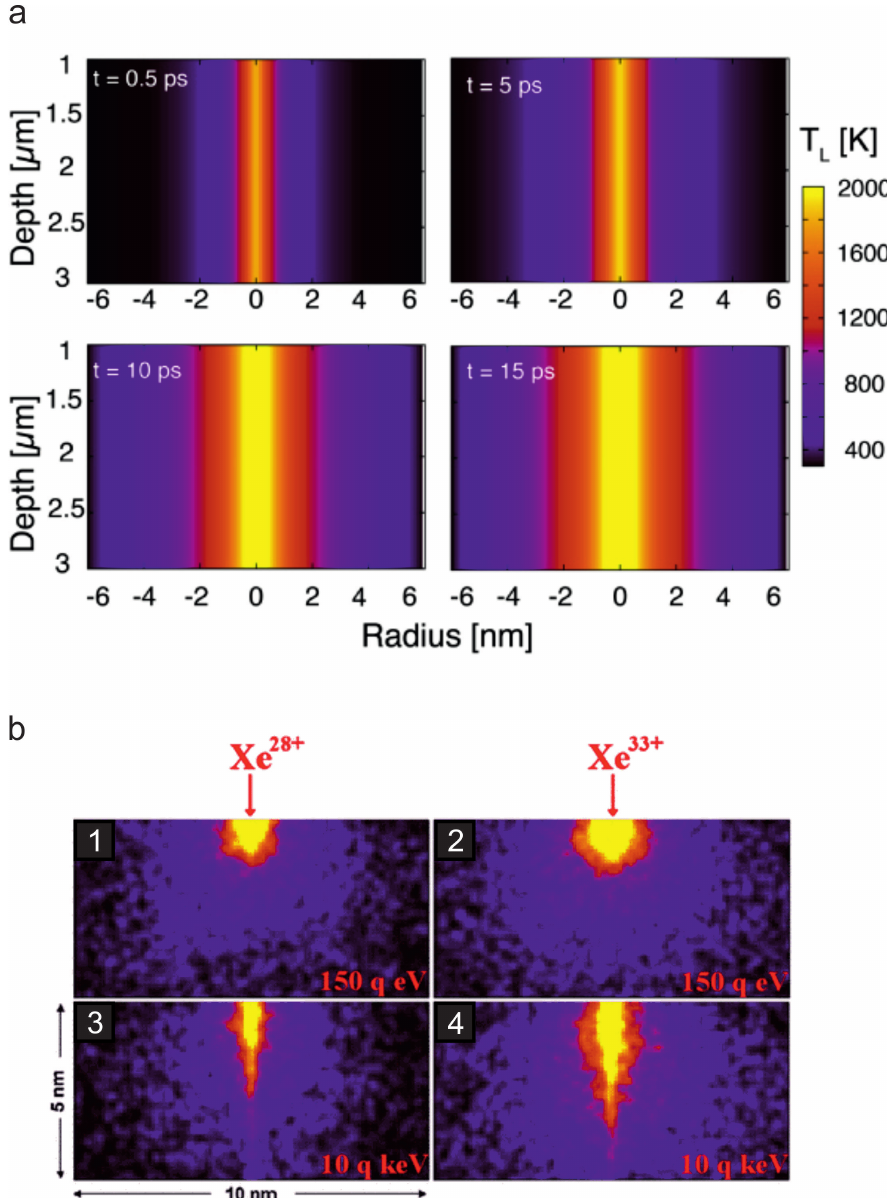
Figure 2. Evolution of the lattice temperatures due to ion impact calculated with the two temperature model showing the different depths of energy deposition of SHI and HCI. ( a ) Lattice temperatures for an SHI (11.4 MeV/amu Ca with dE / dx = 2.6 keV/nm) traversing crystalline SiO 2 . From Ref. [43]. c (cid:13) IOP Publishing. Reproduced with permission. All rights reserved. ( b ) Lattice temperatures for an HCI (Xe 28 + and Xe 33 + ) in CaF 2 for two different kinetic energies (150 × q eV and 10 × q keV). Reprinted with permission from Ref. [44], Copyright (2011) by the American Physical Society. Note the different z -scales for the two different ion